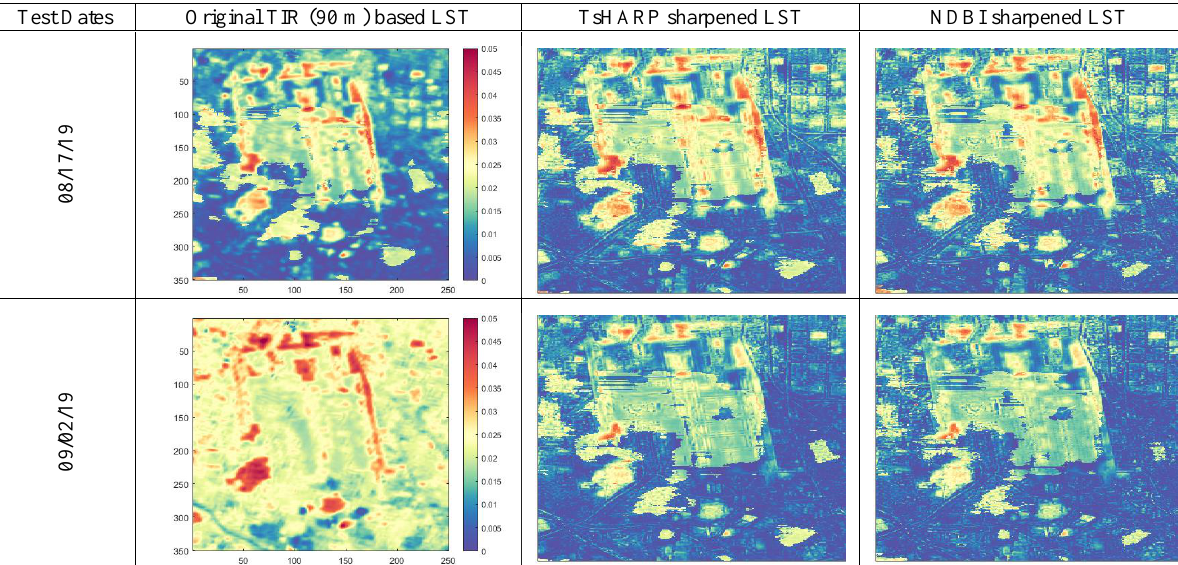
Figure 10. Average difference percentage error of the STF sharpened images using TsHARP, NDBI, and FUC of the Beijing Capital International airport shown in Figure 5. The range of all of the images is 0 and